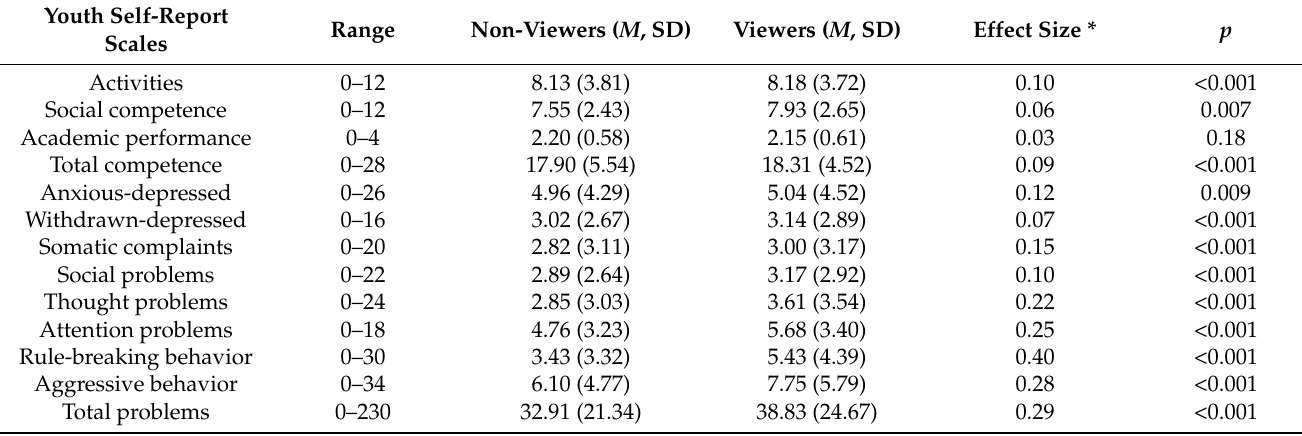
Table 4. Comparison of Youth Self-report scale scores between adolescents who had and had not viewed internet pornogra- phy in the last 12